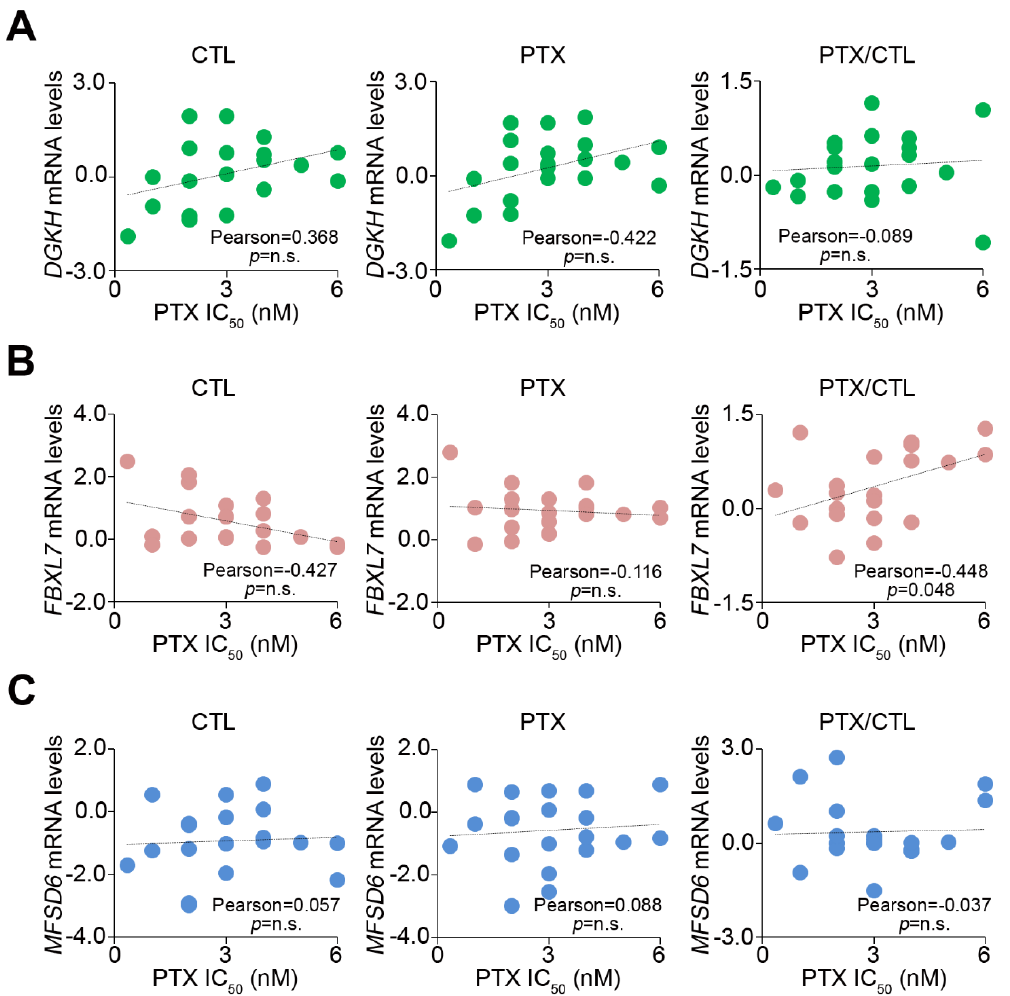
Figure 2. The enhanced expression of FBXL7 positively correlates with PTX IC 50 concentrations in a panel of ovarian cancer cell lines. ( A – C ) Correlations among DGKH , FBXL7 and MFSD6 mRNA level and PTX IC 50 concentration in the tested ovarian cancer cell lines. The statistical significance of correlations was analyzed by using Pearson’s test. The symbol “n.s.” denotes not significant. Each dot in the dotplot indicates the median of mRNA levels from three independent